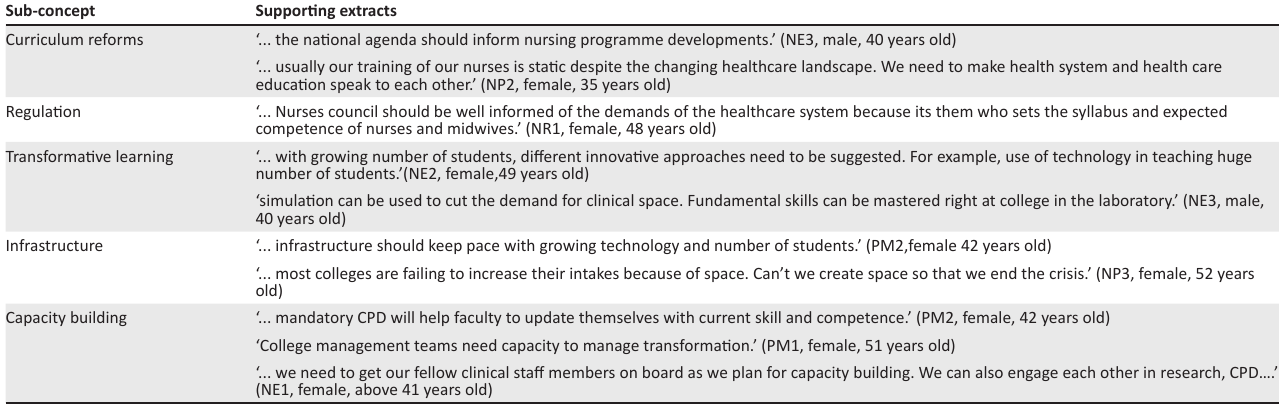
TABLE 3: Showing sub concepts and supporting extracts. Sub-concept Supporting extracts Curriculum reforms